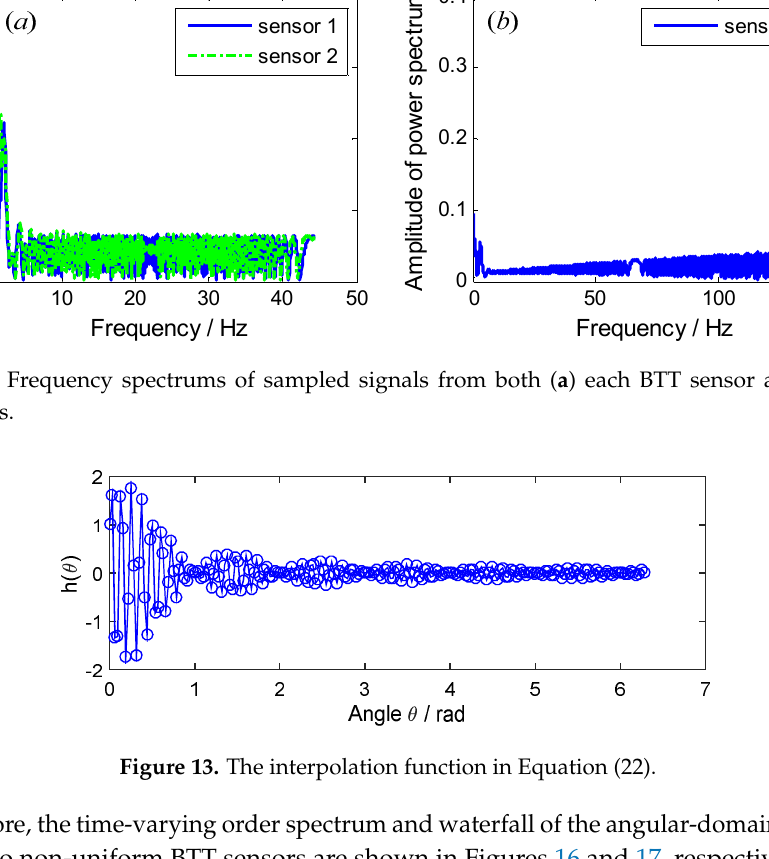
Figure 14. The angular-domain reconstruction signal of the under-sampled BTT signal using two BTT sensors under VRS. Figure 15. Order spectrum of the angular-domain reconstruction signal using two non-uniform BTT sensors under VRS. Furthermore, the time-varying order spectrum and waterfall of the angular-domain reconstruction signal from two non-uniform BTT sensors are shown in Figures 16 and 17, respectively. Compared with Figures 9 and 10, we make a similar conclusion that characteristic 0